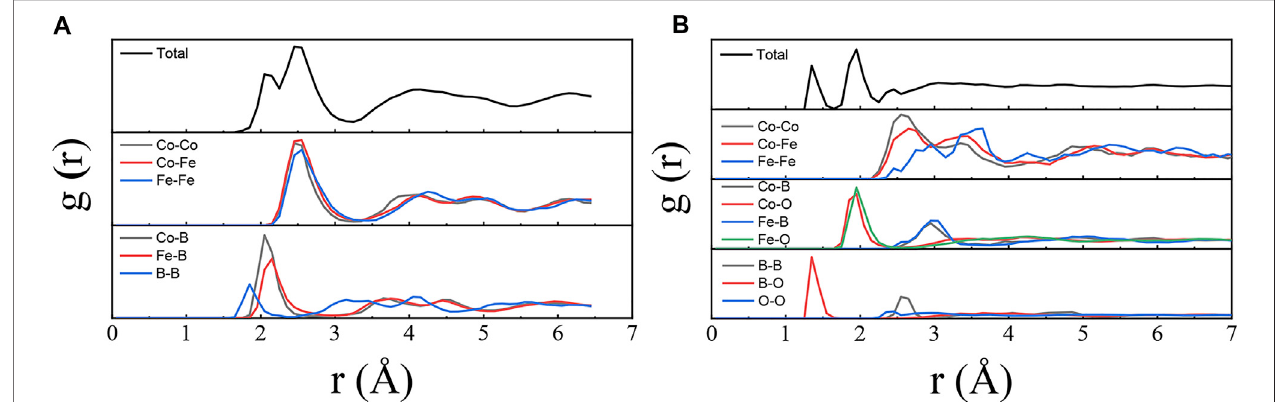
FIGURE 1 | PCFs of (A) Co-Fe-B, (B) Co-Fe-B-O systems at 300 K.